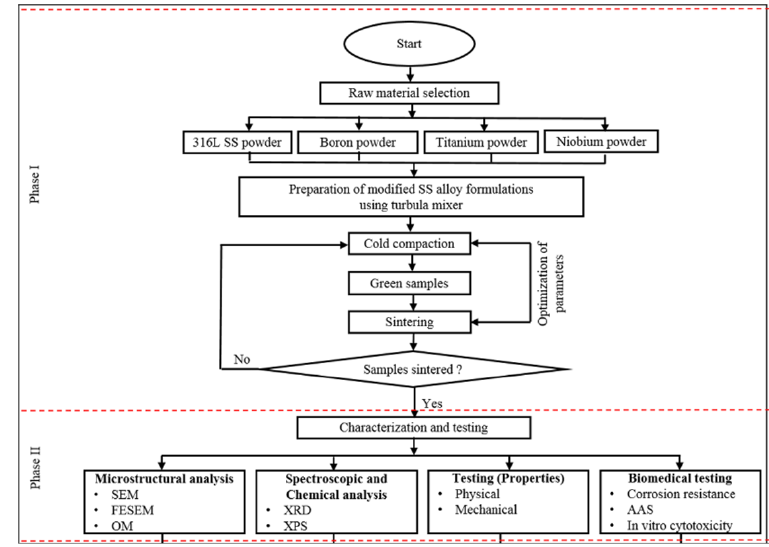
Figure 1. Flow diagram of the whole research methodology.